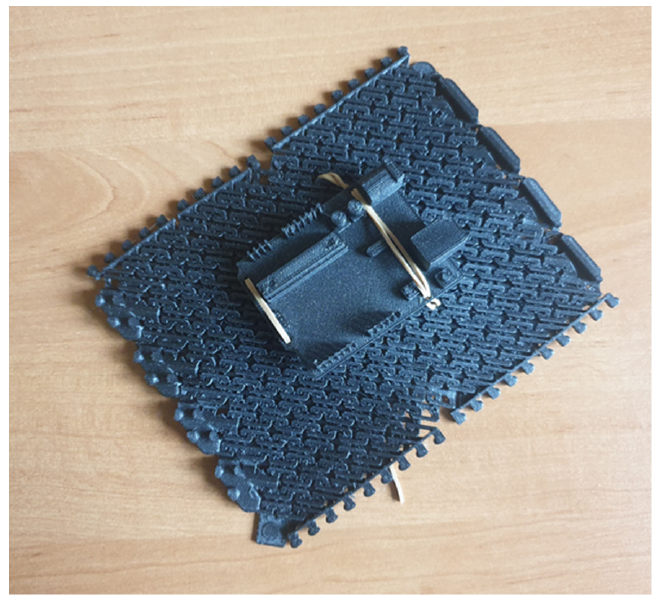
Figure 9. Chainmail as an element of a hand exoskeleton.